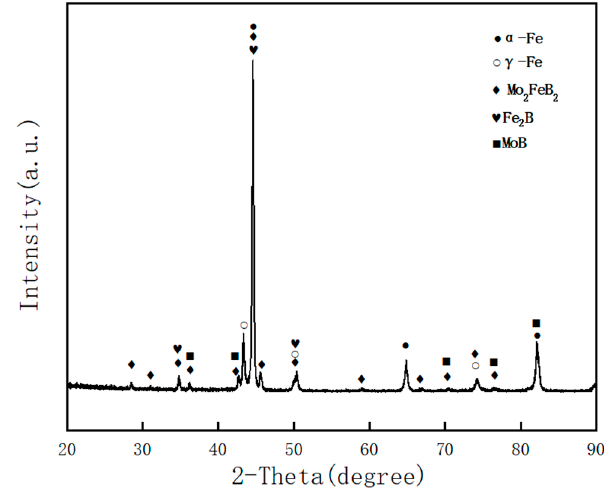
Figure 5. XRD pattern of the Fe–Cr–Mo–Ni–B coating.